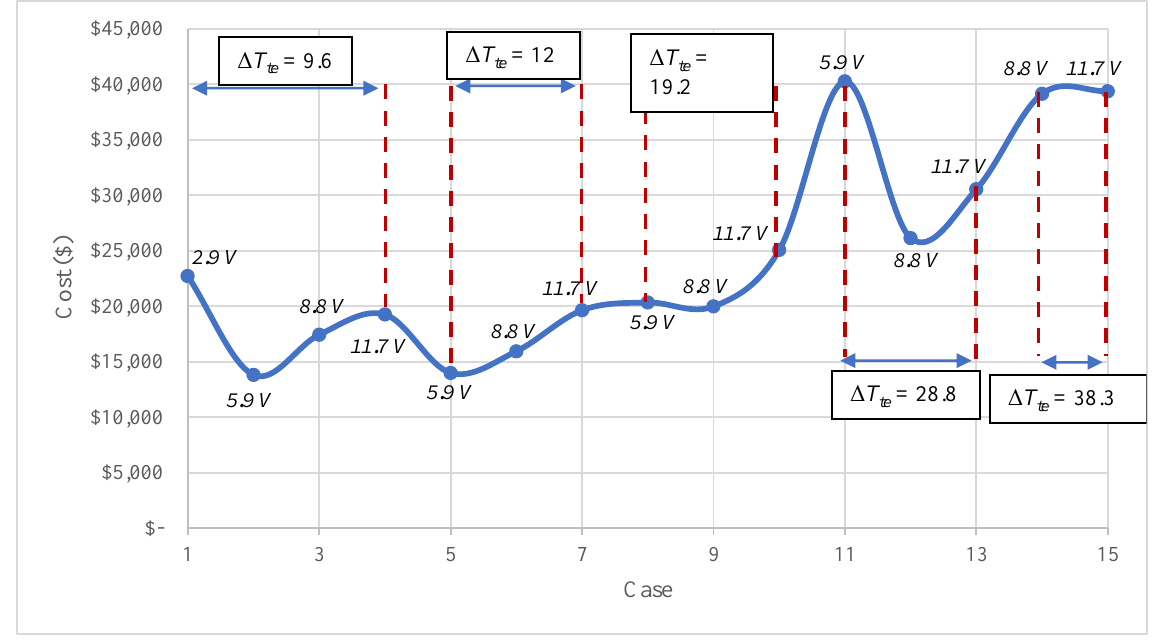
Figure 9. Initial cost of the proposed hybrid PV-TE system.